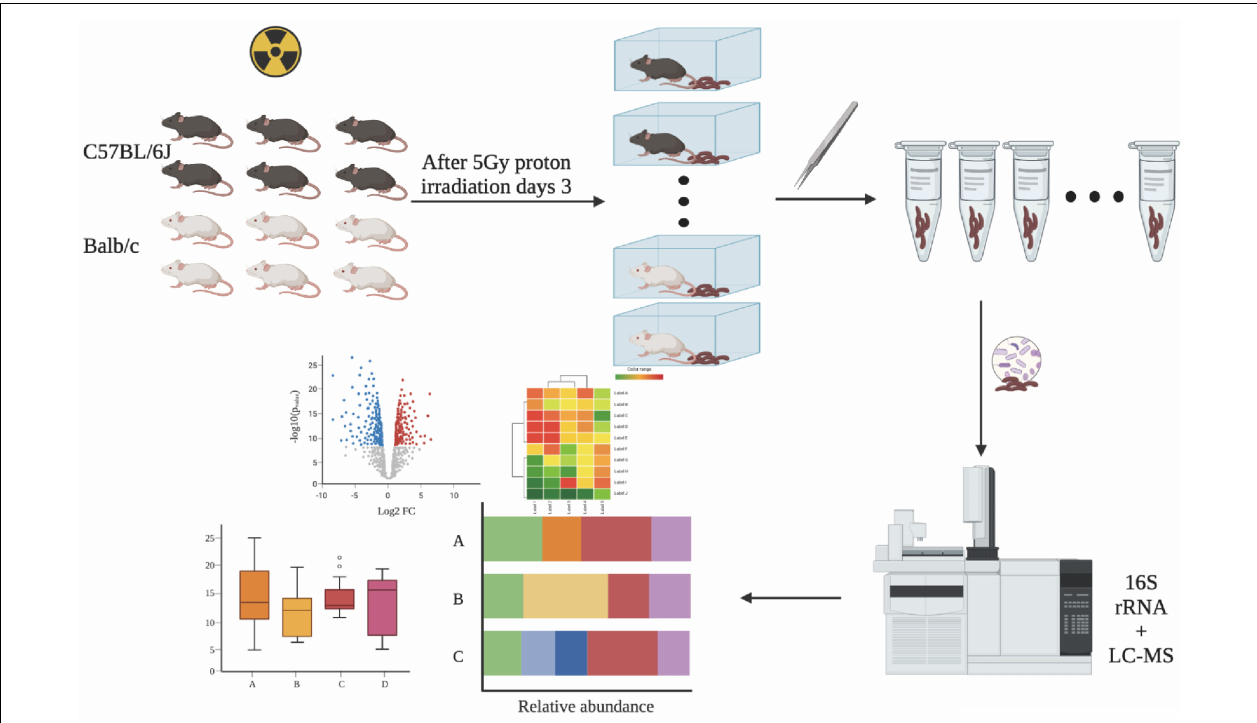
FIGURE 1 | Experimental procedure. Fecal samples were collected from irradiated mice and processed for 16S rRNA amplicon and LC-MS profiling. This image was created with BioRender (https://biorender.com/).